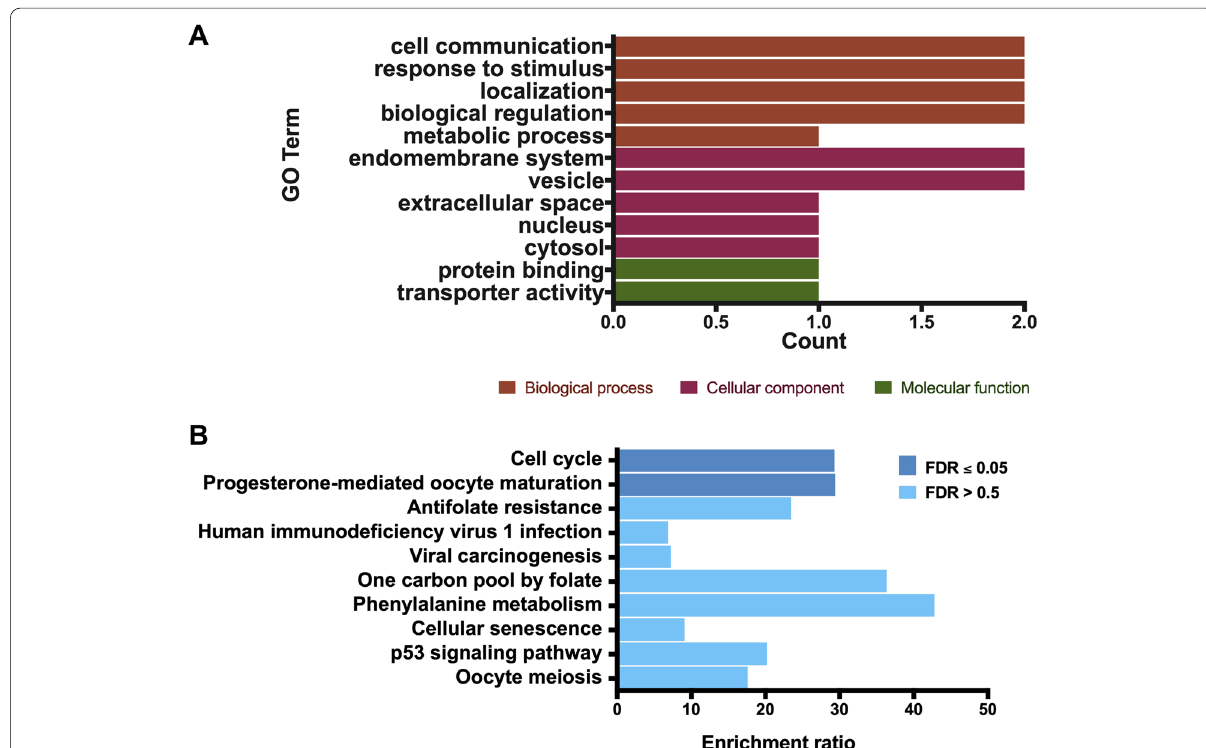
Fig. 3 ( A ) The involvement of CPTGs in biological process (red bar), molecular function (blue bar), and cellular component (green bar) using gene ontology (GO) database. ( B ) Gene enrichment analysis from CPTGs using KEGG pathway which processed through